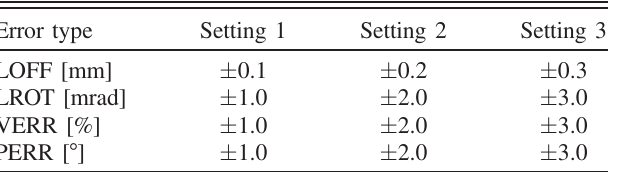
TABLE III. Error ranges used for the three settings.